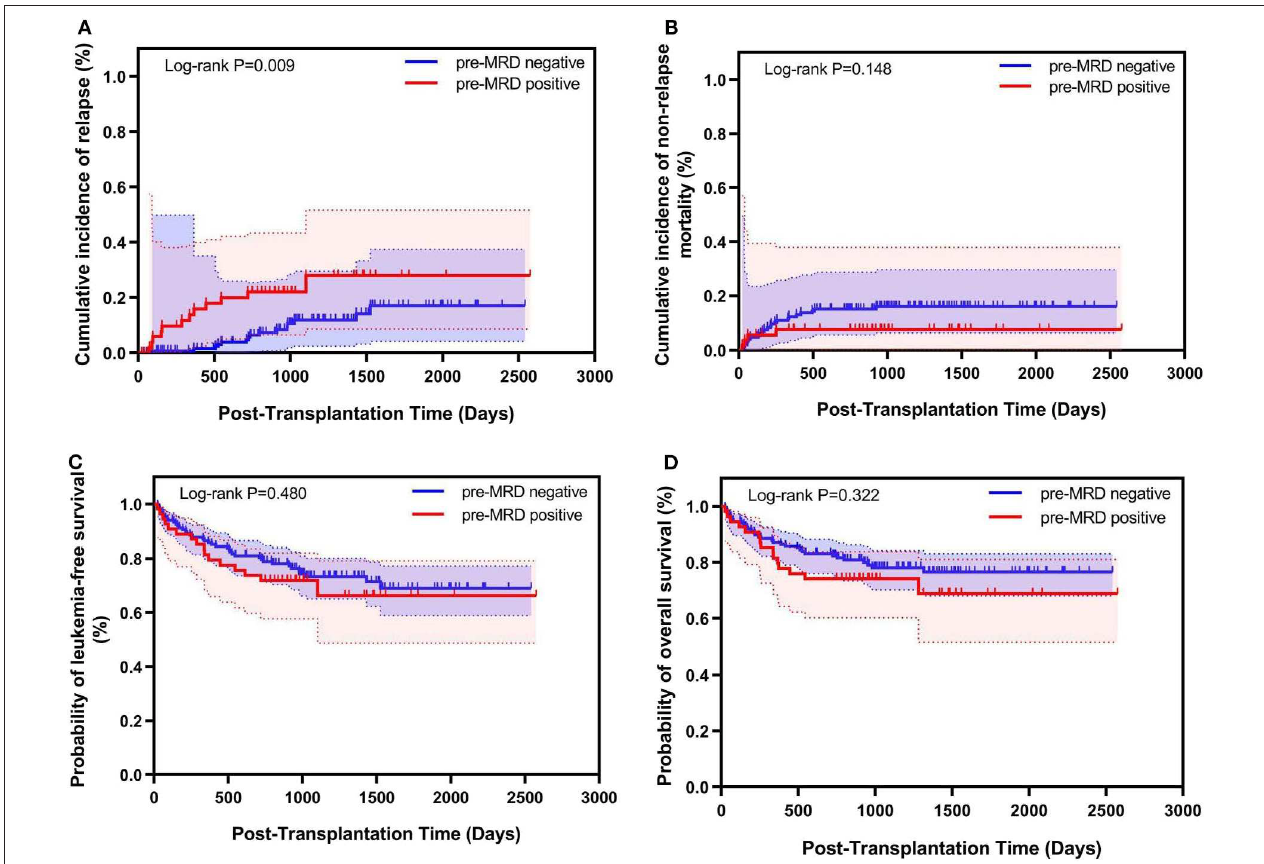
FIGURE 1 | Relationship between pre-transplantation MRD and transplant outcomes for Ph-positive ALL patients who underwent allo-SCT ( n = 202). Kaplan–Meier estimates of (A) cumulative incidence of relapse mortality, (B) cumulative incidence of non-relapse, (C) leukemia-free survival, and (D) overall survival.